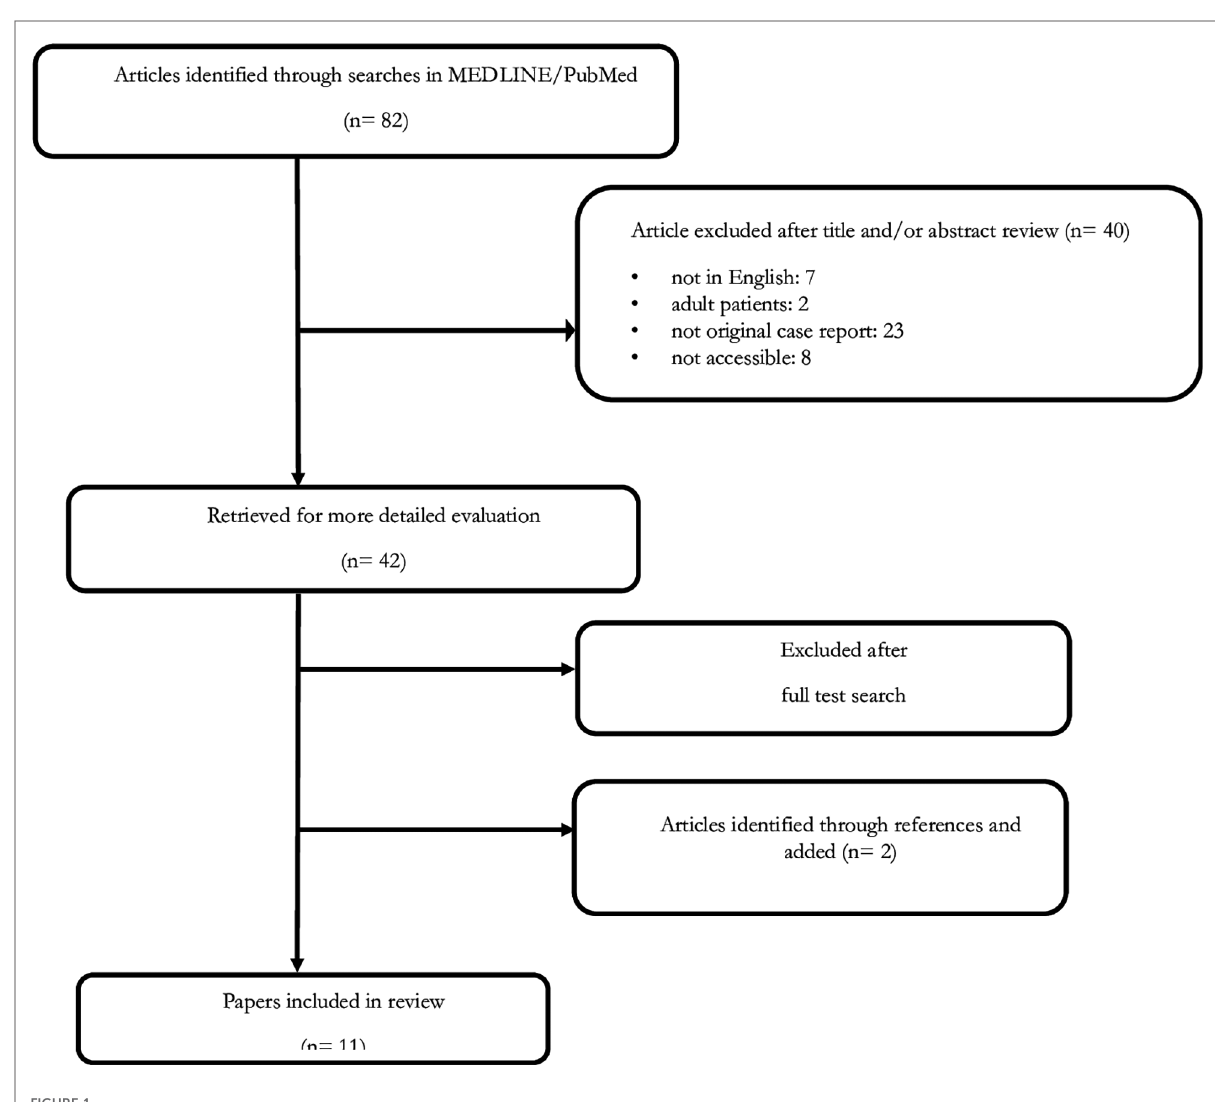
FIGURE 1 Selection process for papers included in the